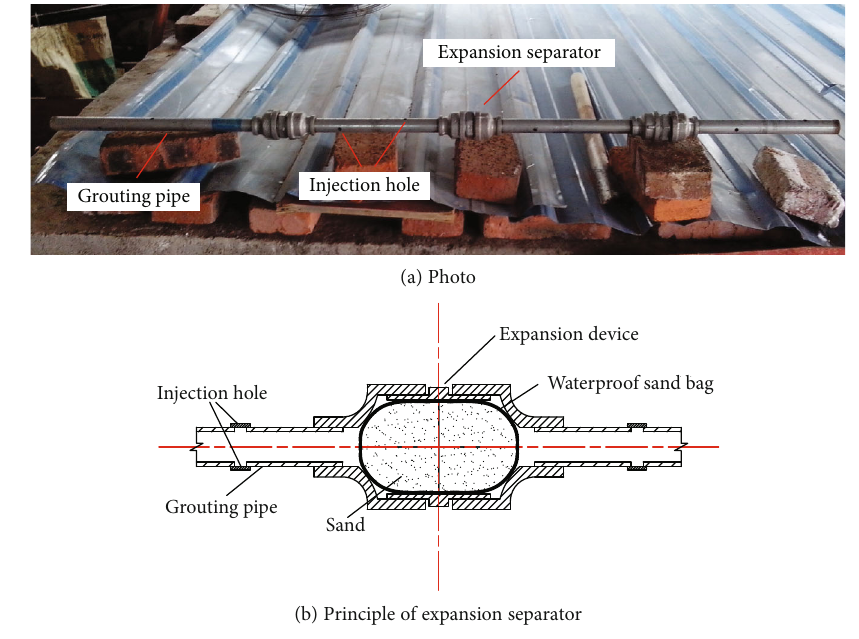
Figure 2: Segmental grouting device in the test frame.